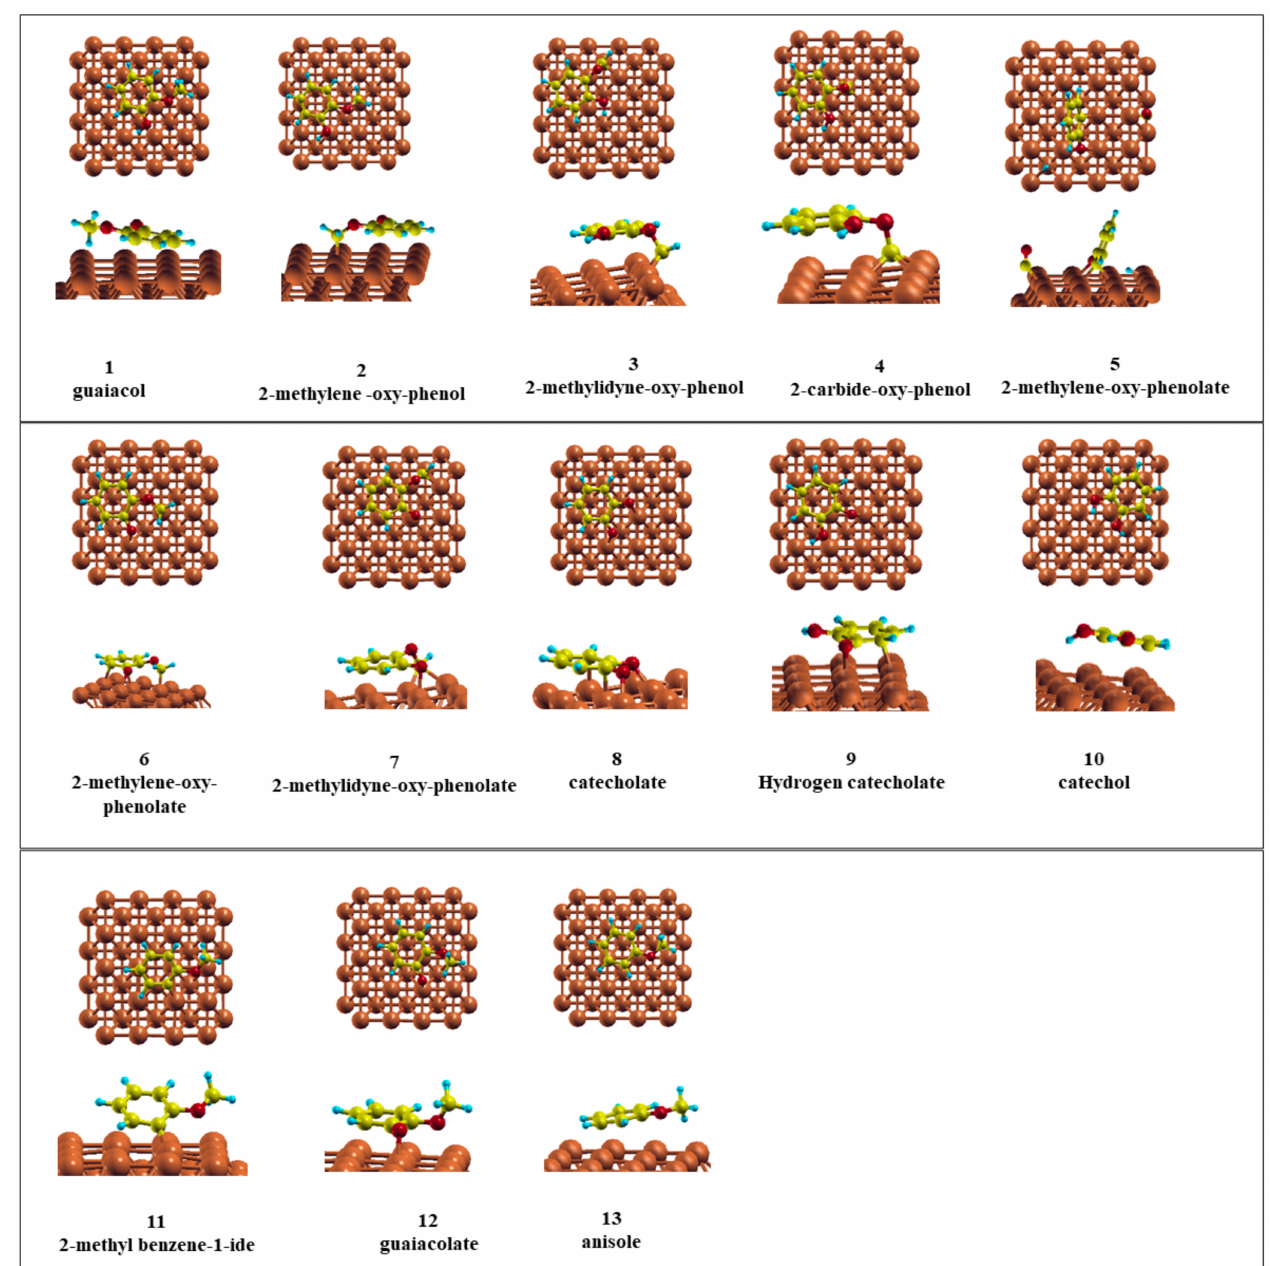
Figure 2. Optimized structures of adsorption complexes viewed from the top and the side. Cu: brown; O: red; C: yellow; H: blue. Structure 5 is not a stable structure on the surface, as it